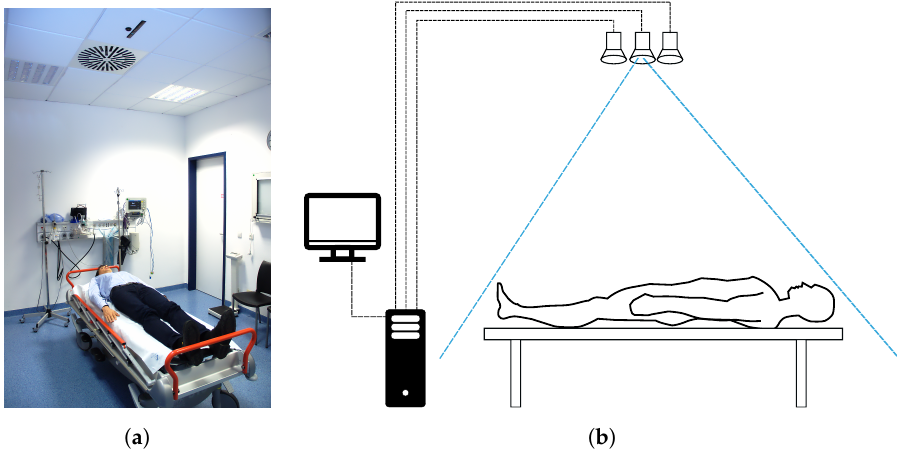
Figure 1. Clinical integration of sensors into the trauma room, as shown in [15]. Within the scenario of trauma room in which physicians mostly treat emergency patients, the sensor system is integrated into the ceiling ( a ); The system does not hinder the physician while treating the patient, who is often lying on a medical stretcher. Besides the sensors in the ceiling, the system consists of a computer system—including a keyboard and a mouse for interaction, a monitor for visualization and a barcode scanner to identify patients with their ID ( b ). The connection between the sensors and the computer is achieved by USB cables. ( a ) Trauma room with sensors integrated into the ceiling; ( b ) Schematic of the sensor system and its connections to a